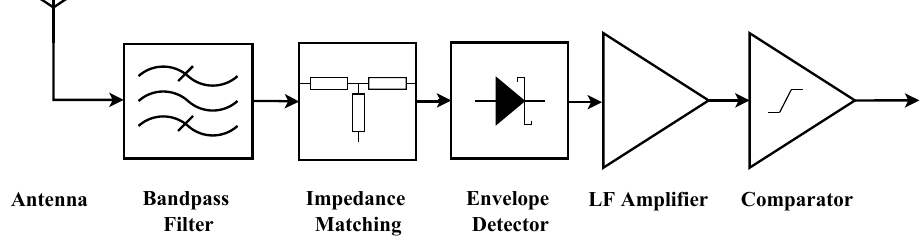
Figure 1. The architecture of the wake-up receiver based on passive components according to